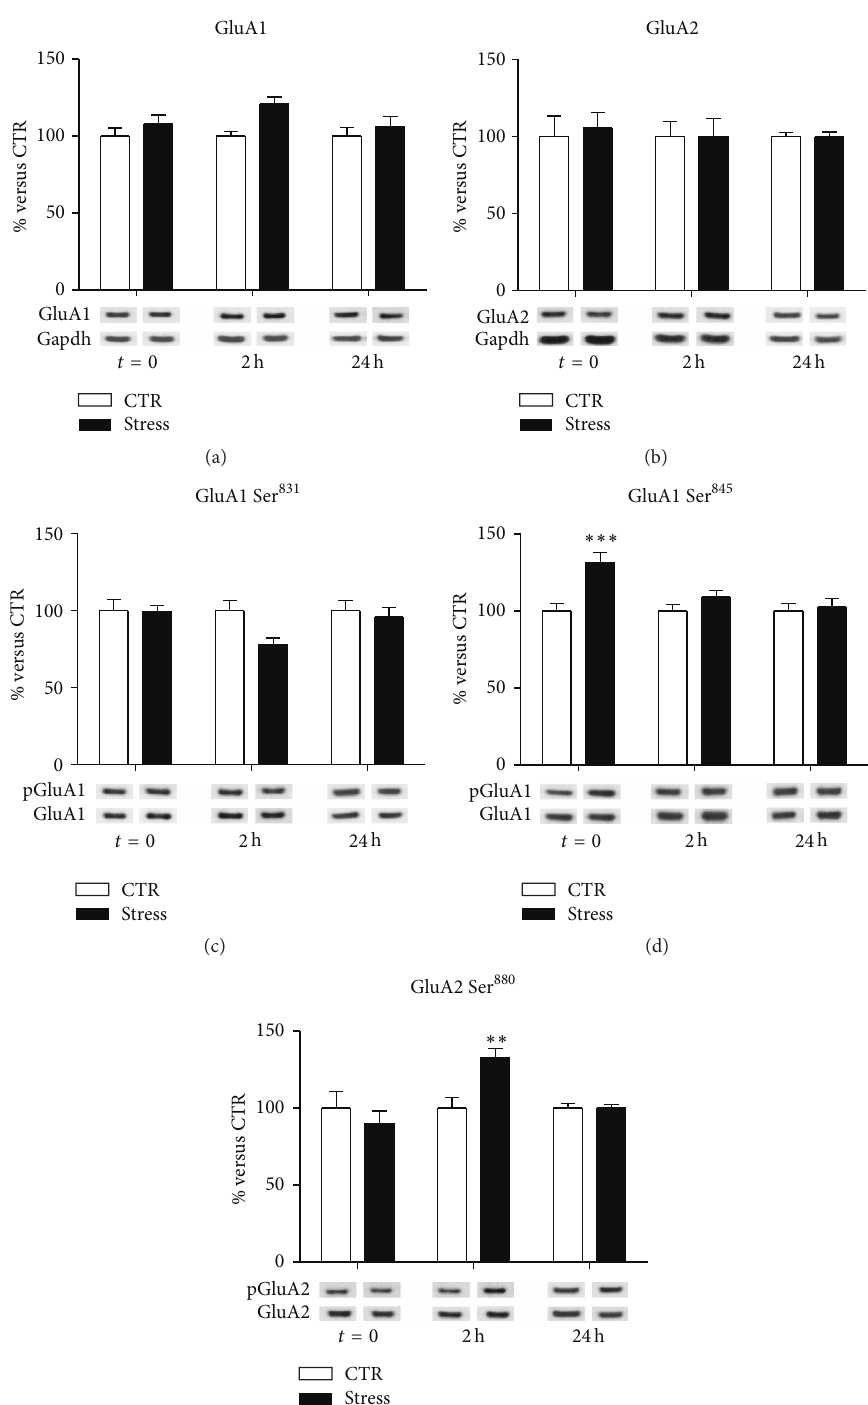
Figure 1: Time-dependent changes of protein expression levels of GluA1 (a), GluA2 (b), GluA1 phospho-Ser 831 (c), GluA1 phospho-Ser 845 (d), and GluA2 phospho-Ser 880 (e) in PFC/FC total homogenate of rats subjected to FS-stress and sacrificed immediately after stress and 2 h and 24 h from stress beginning. Data are represented as percentage of controls at each time point, as means ± SEM ( 𝑛 = 8 ). Statistics: Generalized Linear Models (GLM) and Bonferroni Post Hoc Test (see Section 2 for details). ∗∗ 𝑝 < 0.01 ; ∗∗∗ 𝑝 < 0.001